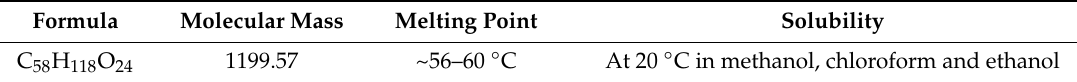
Table 4. Refractive indices of investigated mixtures at 20.4 °C.